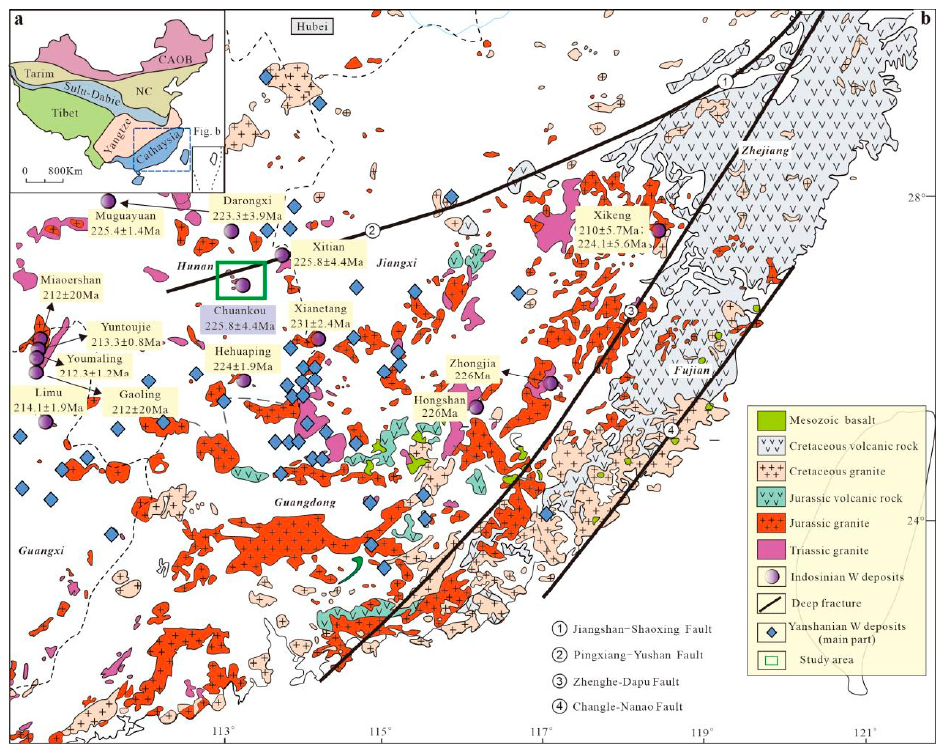
Figure 1. ( a ) Geological block of China and ( b ) Regional geological map of South China. NC, north China Block, SC, south China Block. The green box is the location of this work.